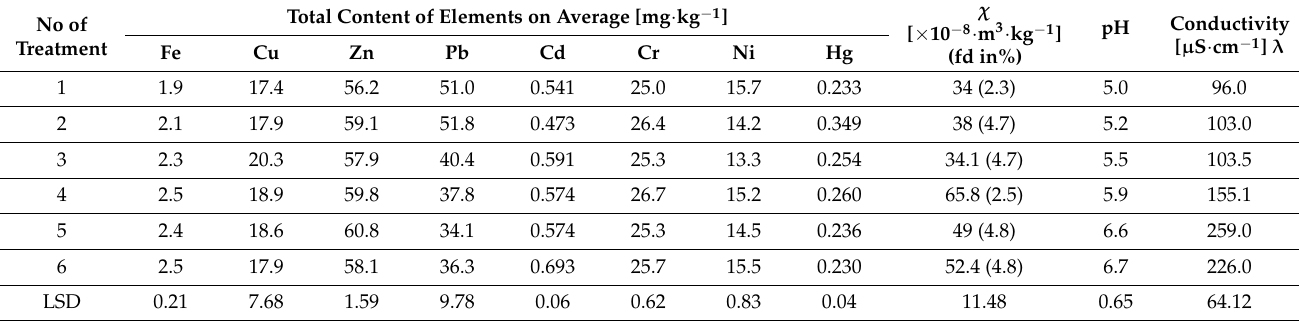
Table 1. Chemical properties of analyzed soil